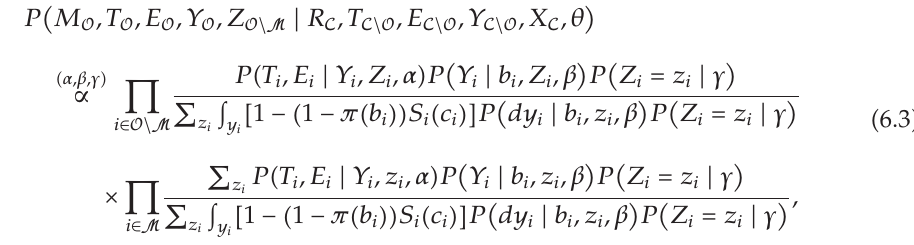
Figure 4: Sampling distributions for maximum likelihood estimates of regression coe ffi cient β 1 from 1000 replications; NPQM model fitted to gamma data (cid:5) Y i ∼ Gamma (cid:5) 4 , 1 (cid:6)(cid:6) .